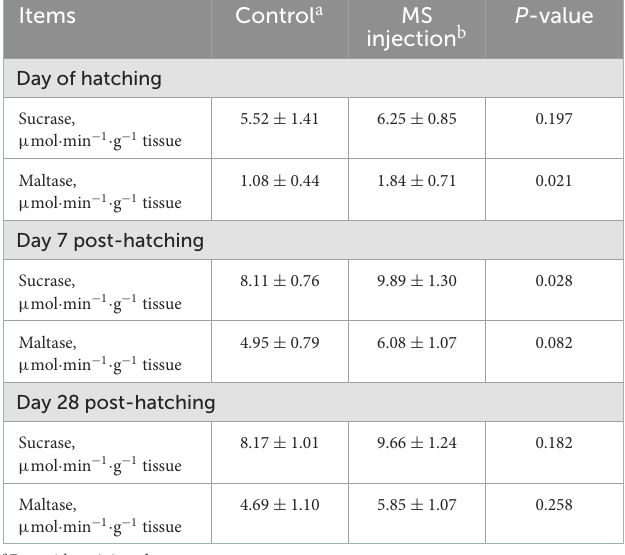
TABLE 5 Post-hatching jejunal disaccharidase activities of goslings as affected by the in ovo injection of maltase and sucrose.